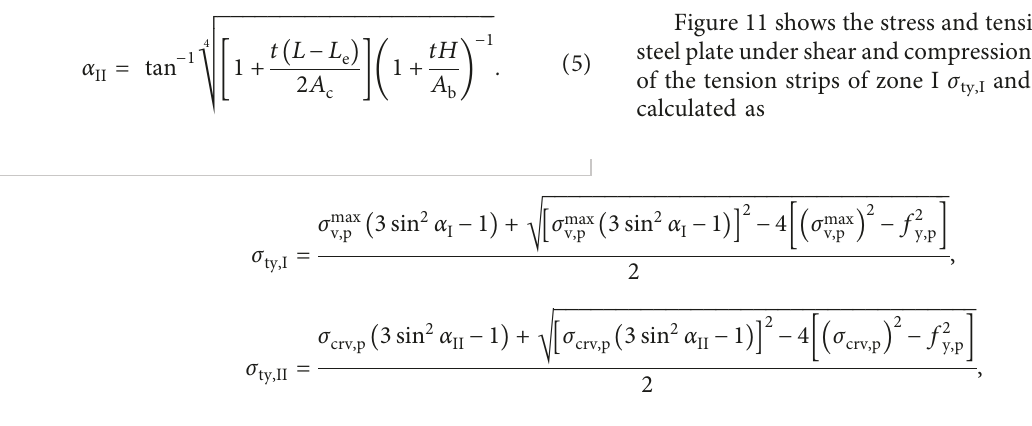
Figure 8: Failure mode of specimen D. (a) Fracture at the support of the column under compression and (b) global out-of-plane buckling of the